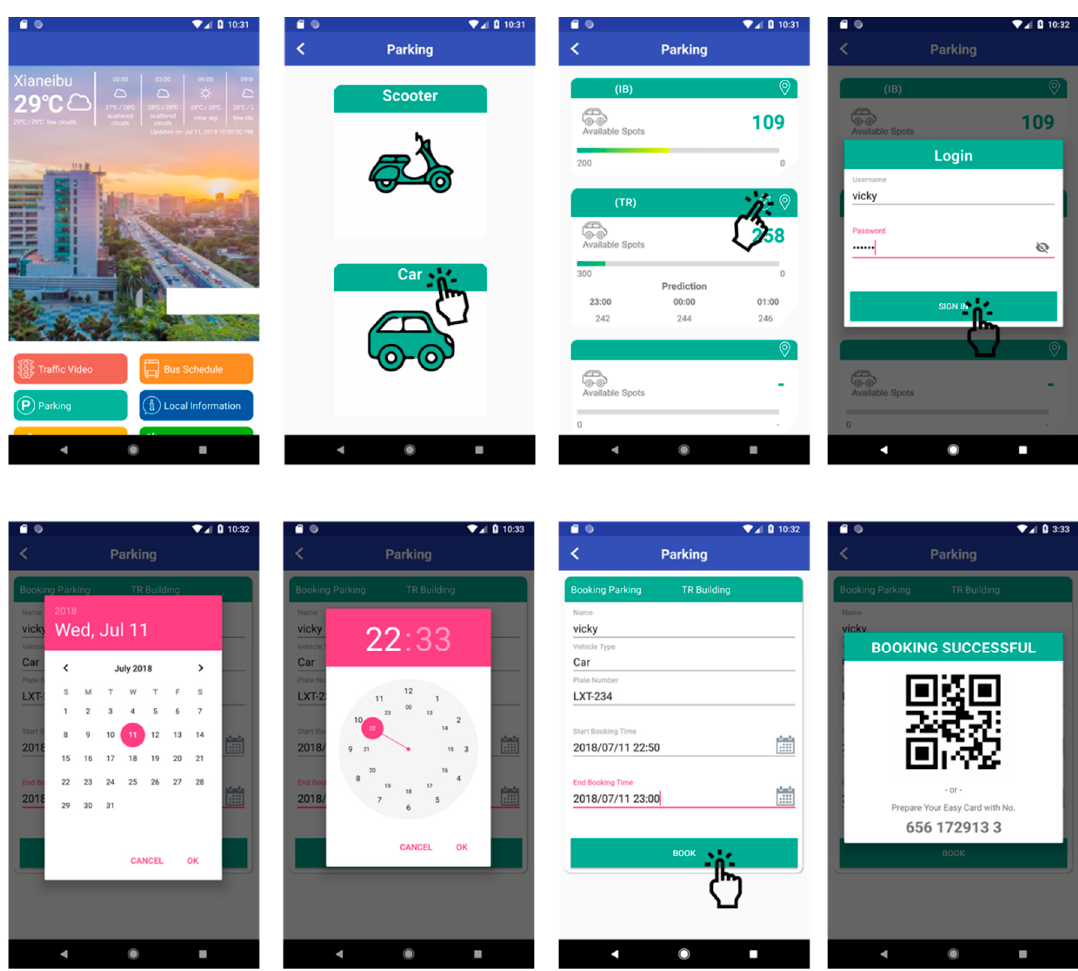
Figure 10. Implementation of reservation based on mobile platform.